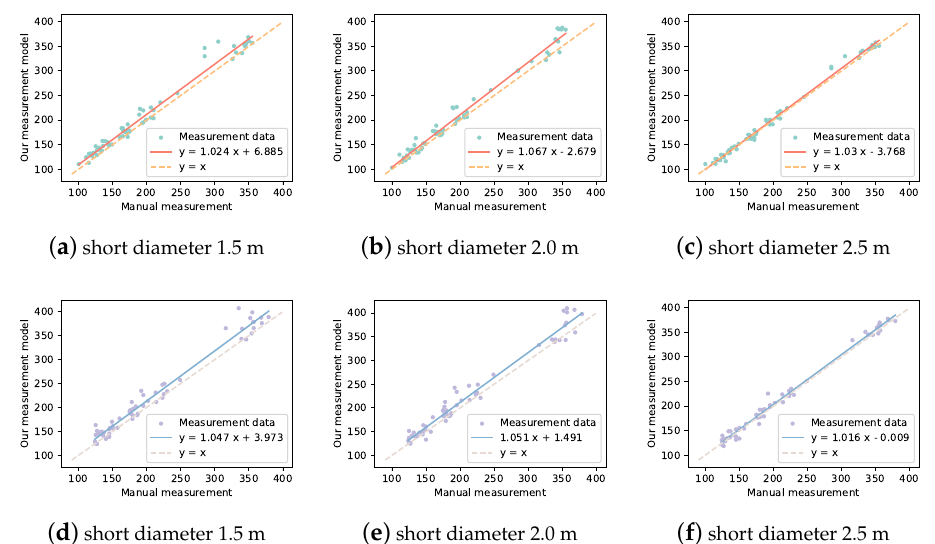
Figure 13. Linear regression of the length of short and long diameter between automatic measurement and manual measurement at different distance (1.5 m, 2 m, 2.5 m).